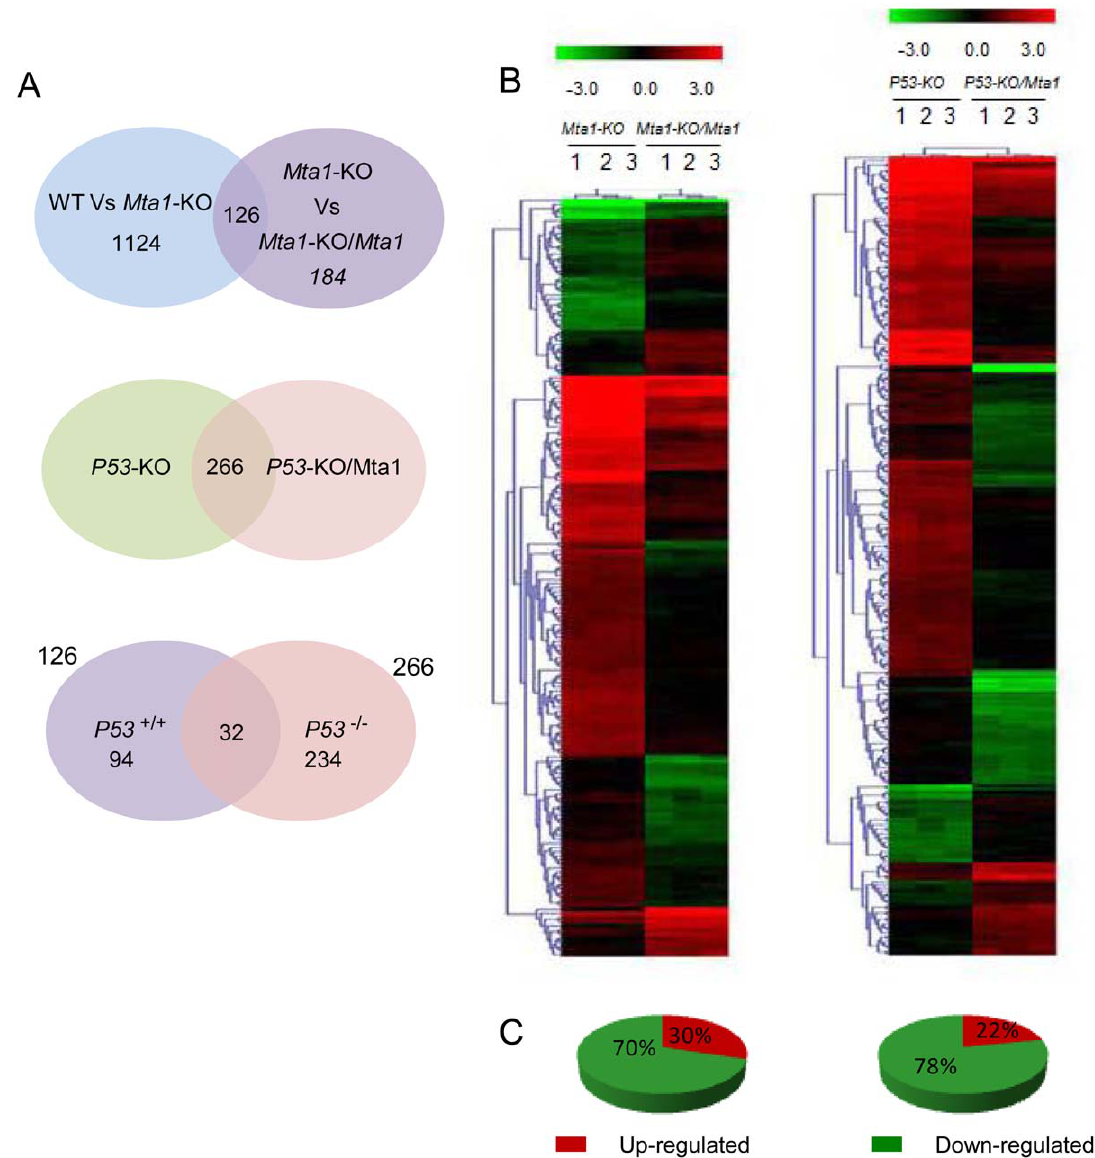
Figure 3. Genes regulated by Mta1 in the presence and absence of P53 . A : Venn diagrams showing the number of genes that are identified to be genuinely regulated by Mta1 in the presence and absence of P53 . (i) The genes shown in WT vs. Mta1 -KO (1124) are the genes affected by Mta1 knock out and the genes that are present in Mta1- KO vs. Mta1- KO /Mta1 (184) are affected due to re-expression of Mta1 in the knockout MEFs. The genes that are differentially regulated in both the sets with opposite trends in the regulation are considered as the ‘bona fide’ genes regulated by Mta1 . ii) Similarly, the intersection of P53 -KO and P53 -KO/ Mta1 represents the genes differentially regulated by Mta1 over expression in the P53- KO MEFs. i.e. the genes regulated by Mta1 in the absence of P53 .This scenario of Mta1 over expression and P53 knock out/mutation mimics most of the cancers iii) The Venn diagram between genes regulated by Mta1 in the presence of P53 , 126 and genes regulated by Mta1 in the absence of P53 , 266 gives the genes that are regulated by Mta1 only in the presence of P53 , irrespective of P53 status and only in the absence of P53 respectively. B : Heat maps representing hierarchical clustering of the differentially regulation, plotted using the log2 values of the genes with p-value # 0.05 (unpaired t- test) and with fold change of at least 2 between the comparisons Mta1 knock out vs. Mta1 knock out/ Mta1 and P53 knock out vs. P53 knock out/Mta1. Each column represents a sample plotted in triplicates and each row in the heat map represents a gene that is differentially regulated in that particular comparison of samples. The color scale represents the degree of expression of the gene, green being the lowly expressed (below 2 3.0) and red being (above + 3.0) the highly expressed genes in the sample sets with black as the center of the scale at ‘0’. C : Pie diagrams showing the percentage of up-regulated and the down-regulated genes in each sample comparison. The red segment of the pie represents the up-regulated genes whereas; the green segments represent the down regulated genes.